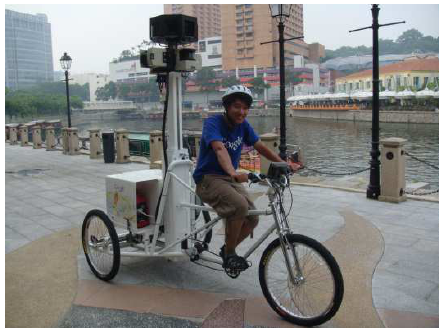
Figure 2. Coal pollution vs Road traffic accidents in EU [source Internet]